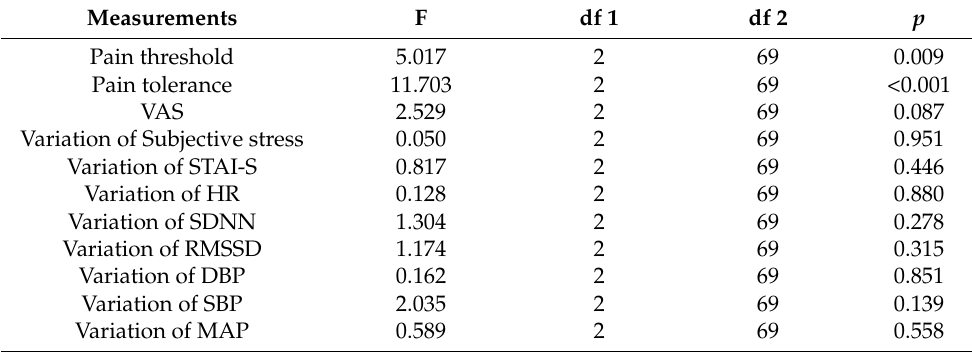
Table 3. Fixed effects of setting on the measured indices.